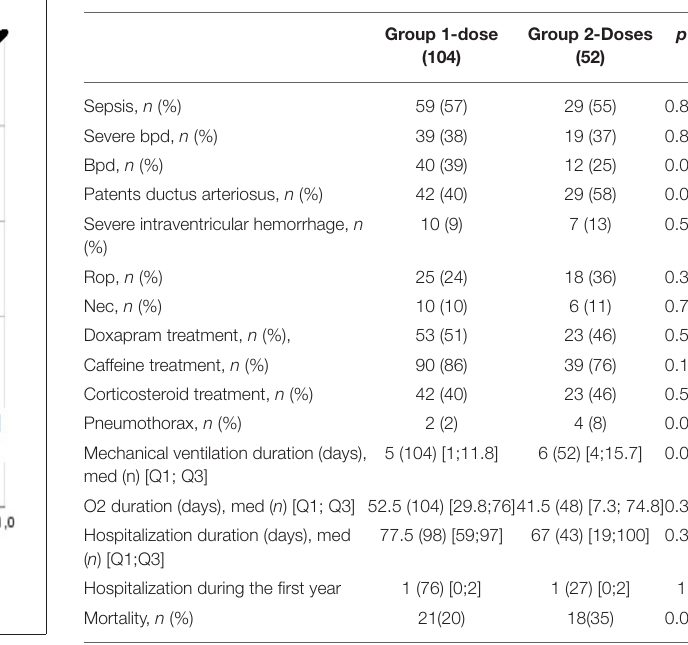
TABLE 4 | Neonatal